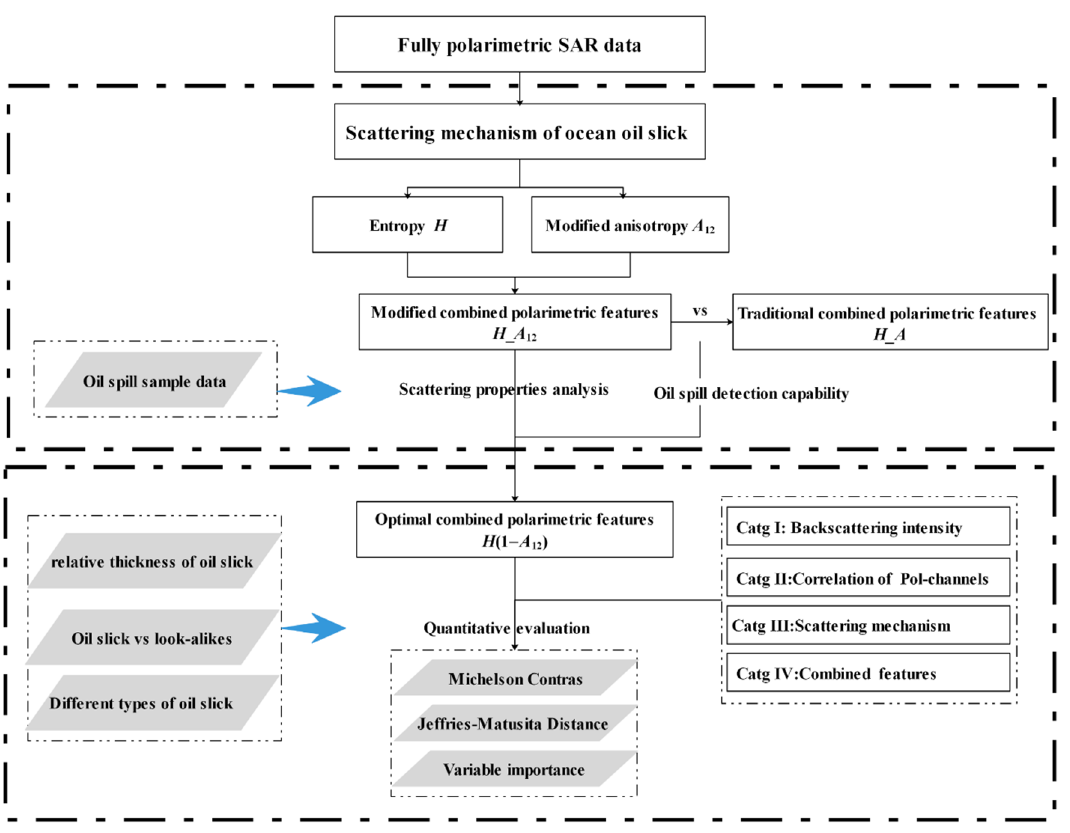
Figure 3. Flow charts outlining the proposed method.